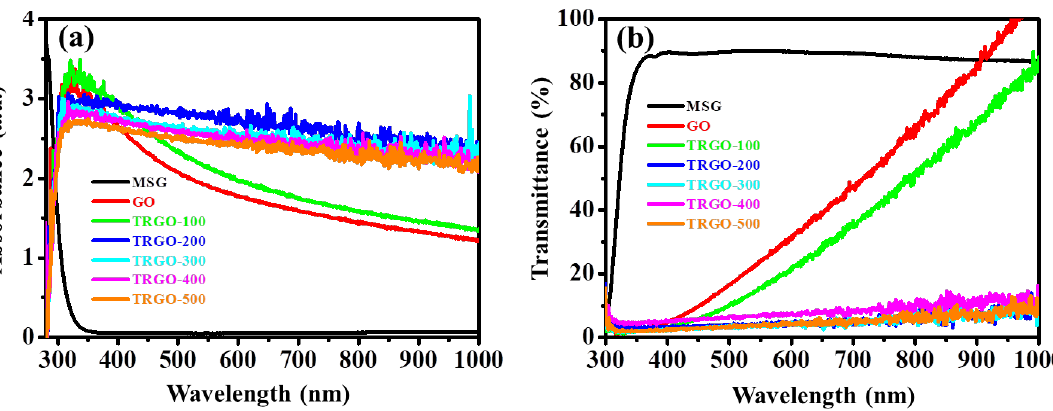
Figure 4. UV-Vis. ( a ) Absorbance and ( b ) transmittance of the GO, MSC, and TRGO-100 to TRGO –